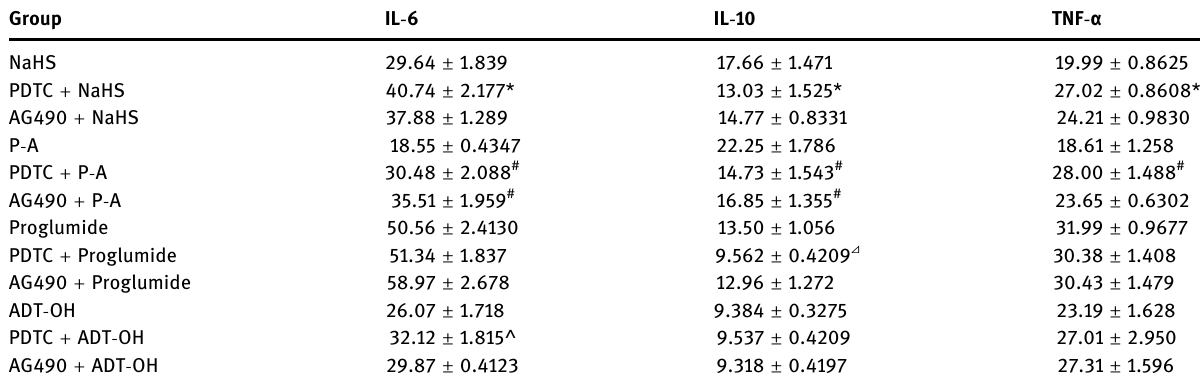
Table 4: Detection of IL - 6, IL - 10, and TNF - α after adding AG490 and PDTC in HUVEC damage model ( x ¯ ± S, pg/mL, n = 5 ) Group IL -